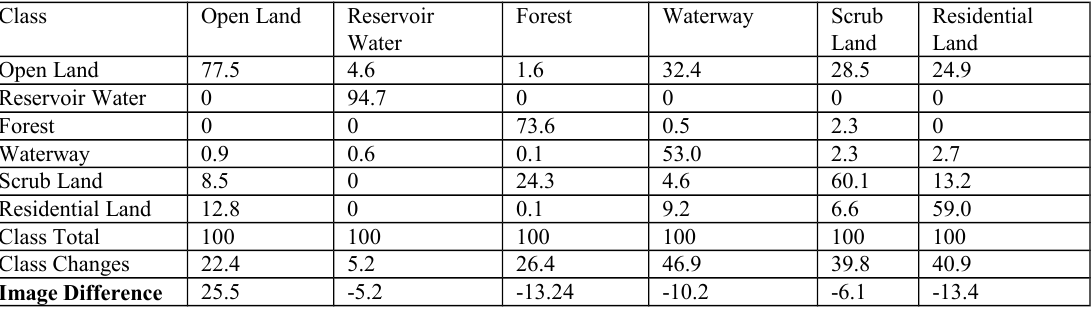
Table 7: Summer to Autumn Season Change Detection